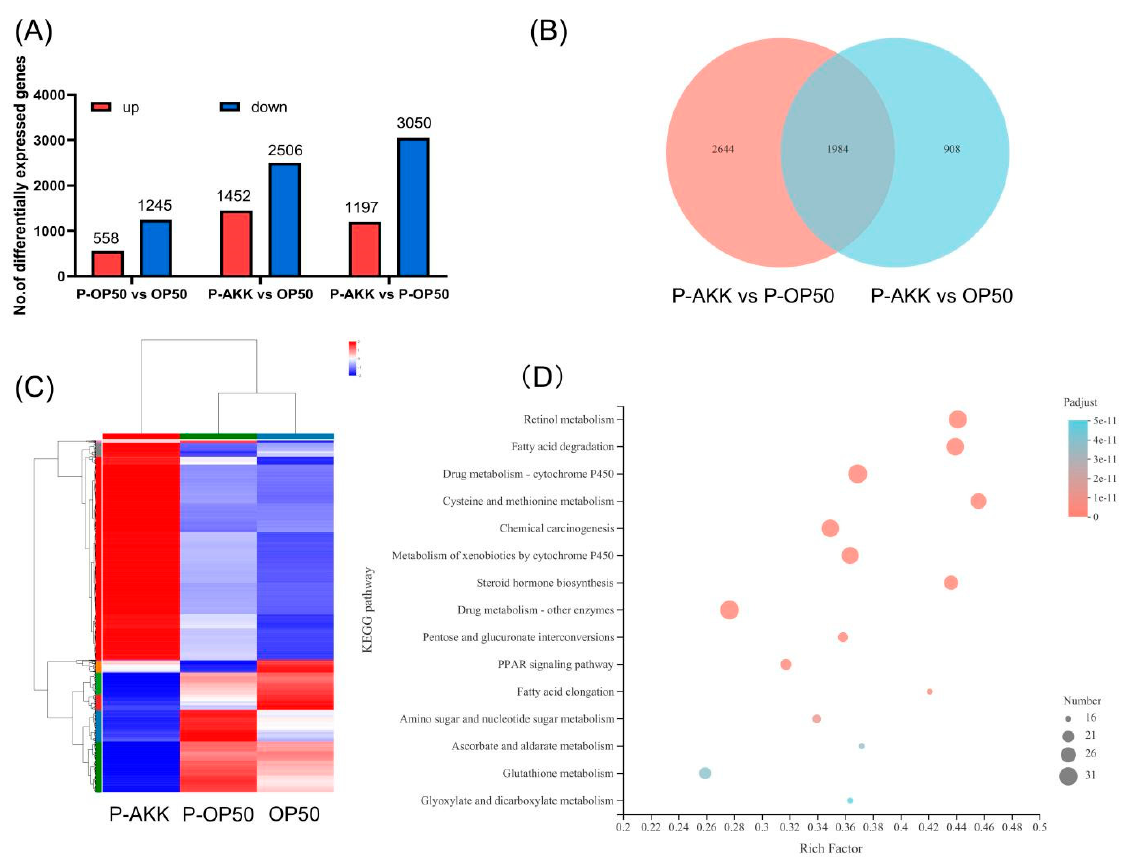
Figure 5. Changes in gene expression profiles of worms fed different bacteria affect energy metabolism. ( A ) Numbers of DEGs in pairwise comparisons of three treatments. ( B ) Venn diagram showing the number of DEGs in different treatments. ( C ) Heatmap diagrams showing relative expression levels of total DEGs among three treatments. ( D ) Top 15 statistics of KEGG pathway enrichment analysis of worms fed p ‐ AKK and p ‐ OP50.